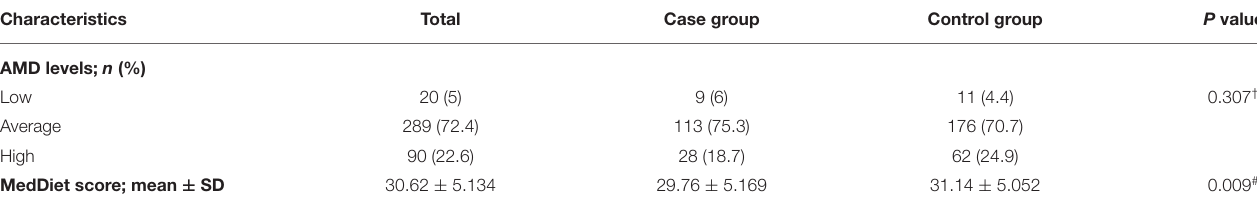
TABLE 2 | Adherence to the Mediterranean diet and MedDiet score of the participants. Characteristics